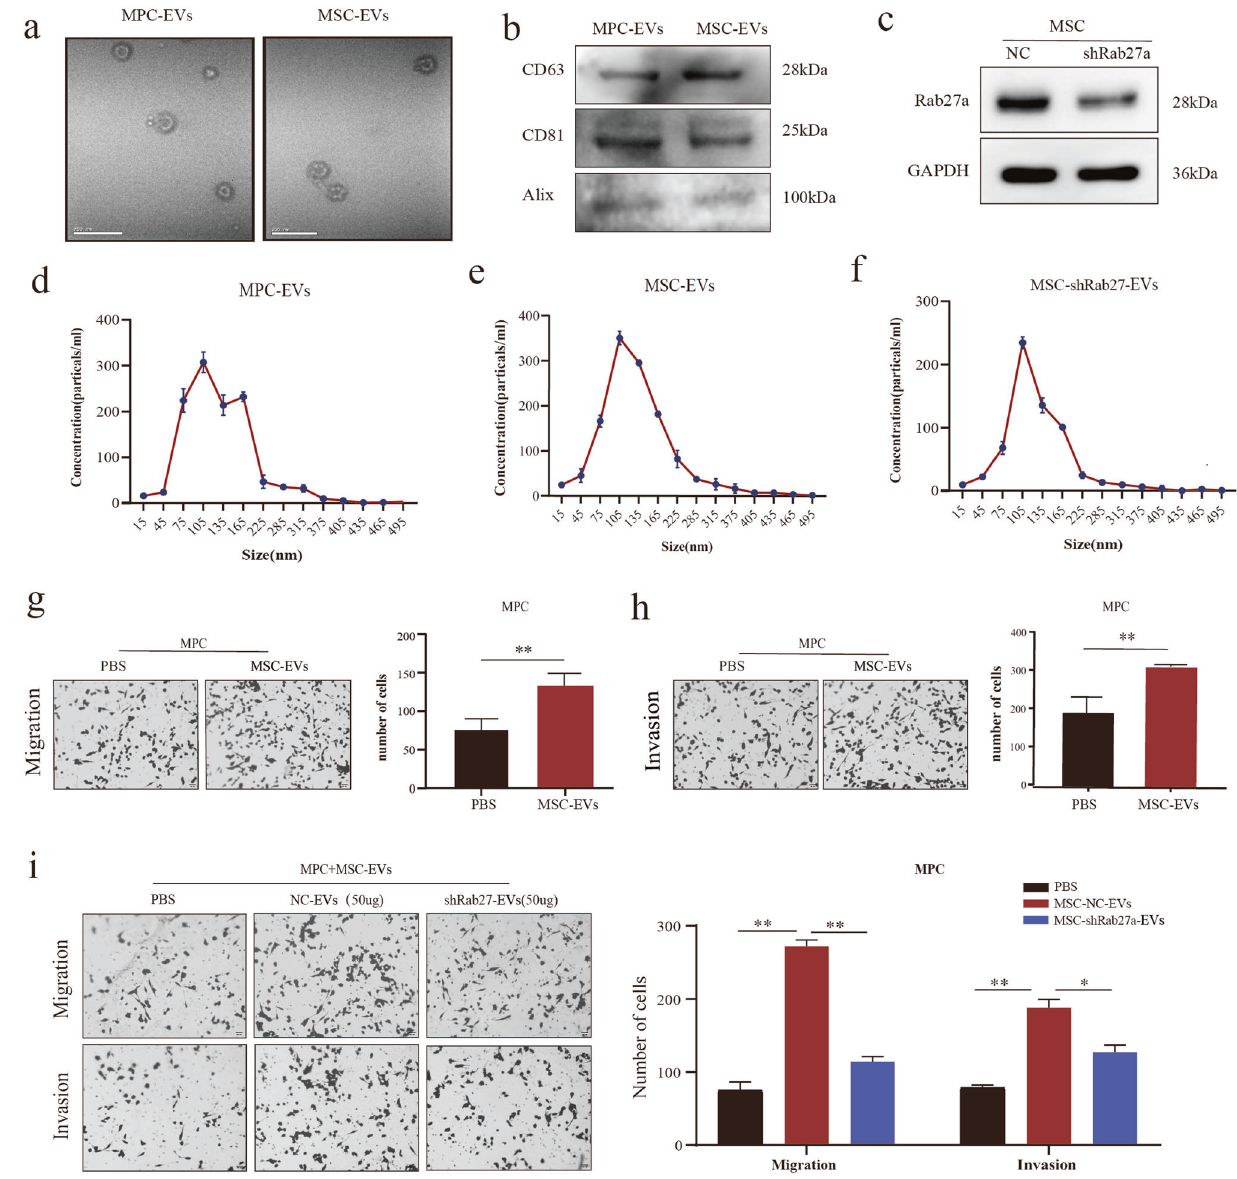
Fig. 1 EVs from MSCs enhance the invasiveness of non-CSC MPCs. a EVs isolated from MPCs and MSCs were observed by transmission electron microscopy. b EVs marker proteins were detected by western blot. c Rab27a knockdown ef fi ciency. d – f EVs particle size and concentration (1 × 10 6 – 5 × 10 6 ) were identi fi ed by Nanoparticle Tracking Analysis. g MSC-EVs enhanced the migration ability of MPCs, P < 0.01. h MSC-EVs enhanced the invasion ability of MPCs, P < 0.01. i The effect of shRab27-MSC-EVs (50 ug, 24 h) on MPCs migration and invasion. (ns not signi fi cant; * P < 0.05; ** P < 0.01; *** P <